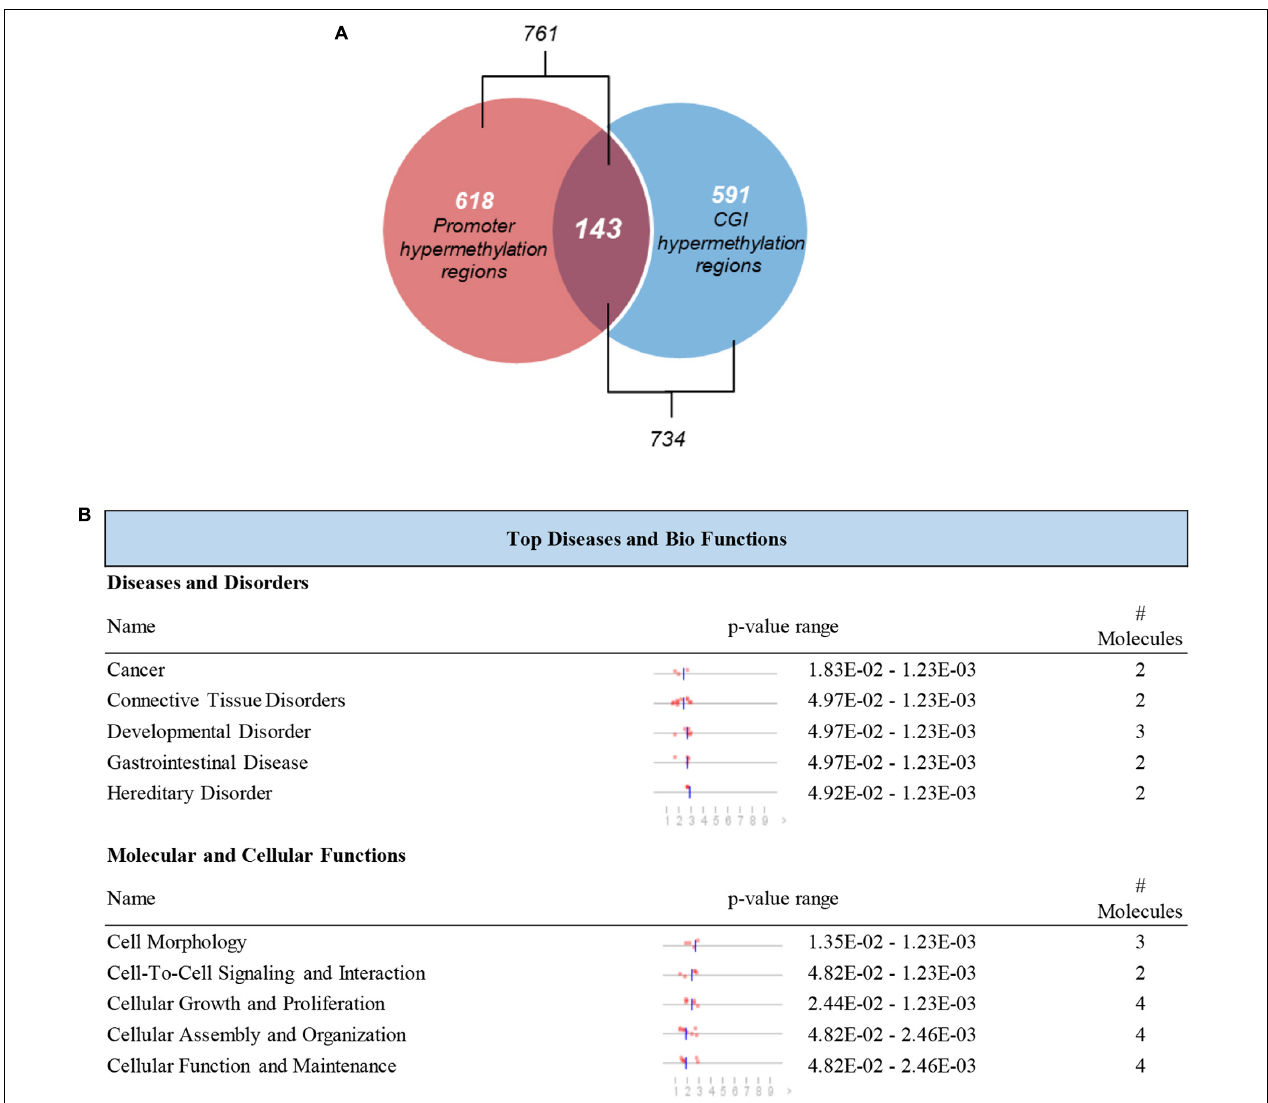
FIGURE 5 | Selection and definition of differentially methylated genes in both the CGIs and promoter regions. (A) Hypermethylated DMRs in the overlap of promoter regions and CGIs. (B) Top disease and bio functions by IPA analysis for genes derived from hypermethylated DMRs located in both the promoter regions and CGIs.